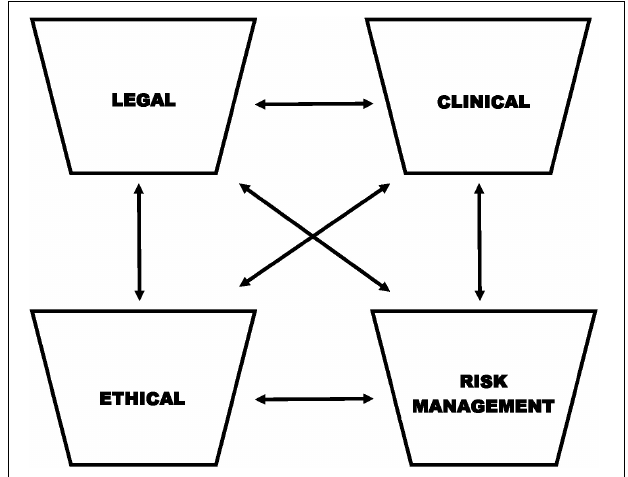
FIGURE 1 | Adapted from Behnke’s “four-bin” model. Considerations include the differentiation and integration of: legal (federal and state law), clinical (assessment and treatment interests of the client), ethical (American Psychological Association Principles of Psychologists and Code of Conduct), and risk management (potential liability issues) issues and